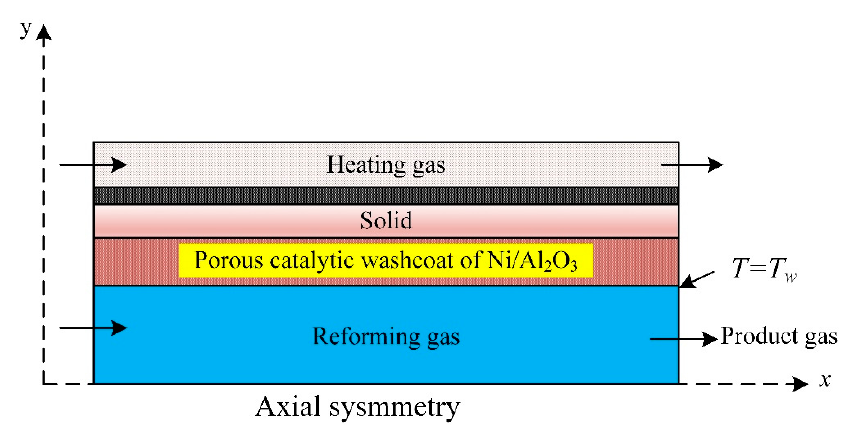
Figure 5. Microchannel reactor for methane steam reforming simulated with CFD [65].